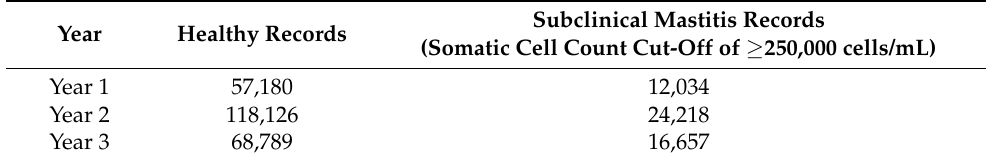
Table 1. Number of healthy and subclinical mastitis records, collected over 3 years during the study.